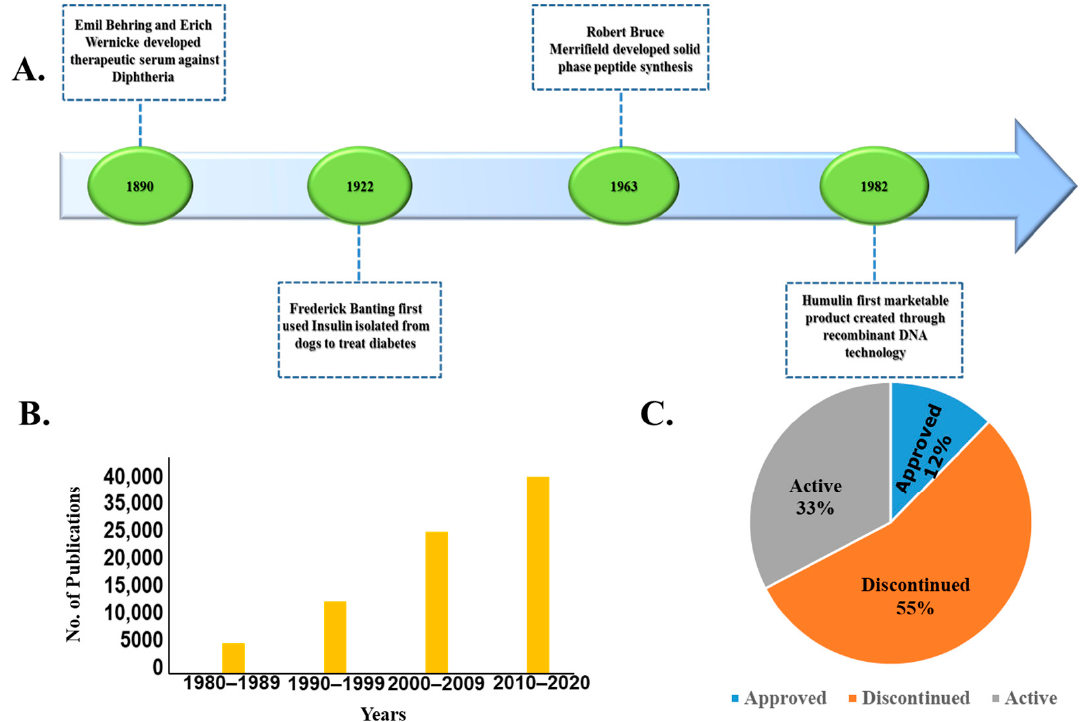
Figure 1. The burgeoning field of protein- and peptide-based therapeutics. ( A ): Key developments in the field; ( B ): number of publications on “oral delivery of peptides and proteins” in PubMed, arranged by decade from 1980 to the present; ( C ) Status of clinical trials of peptides and proteins.